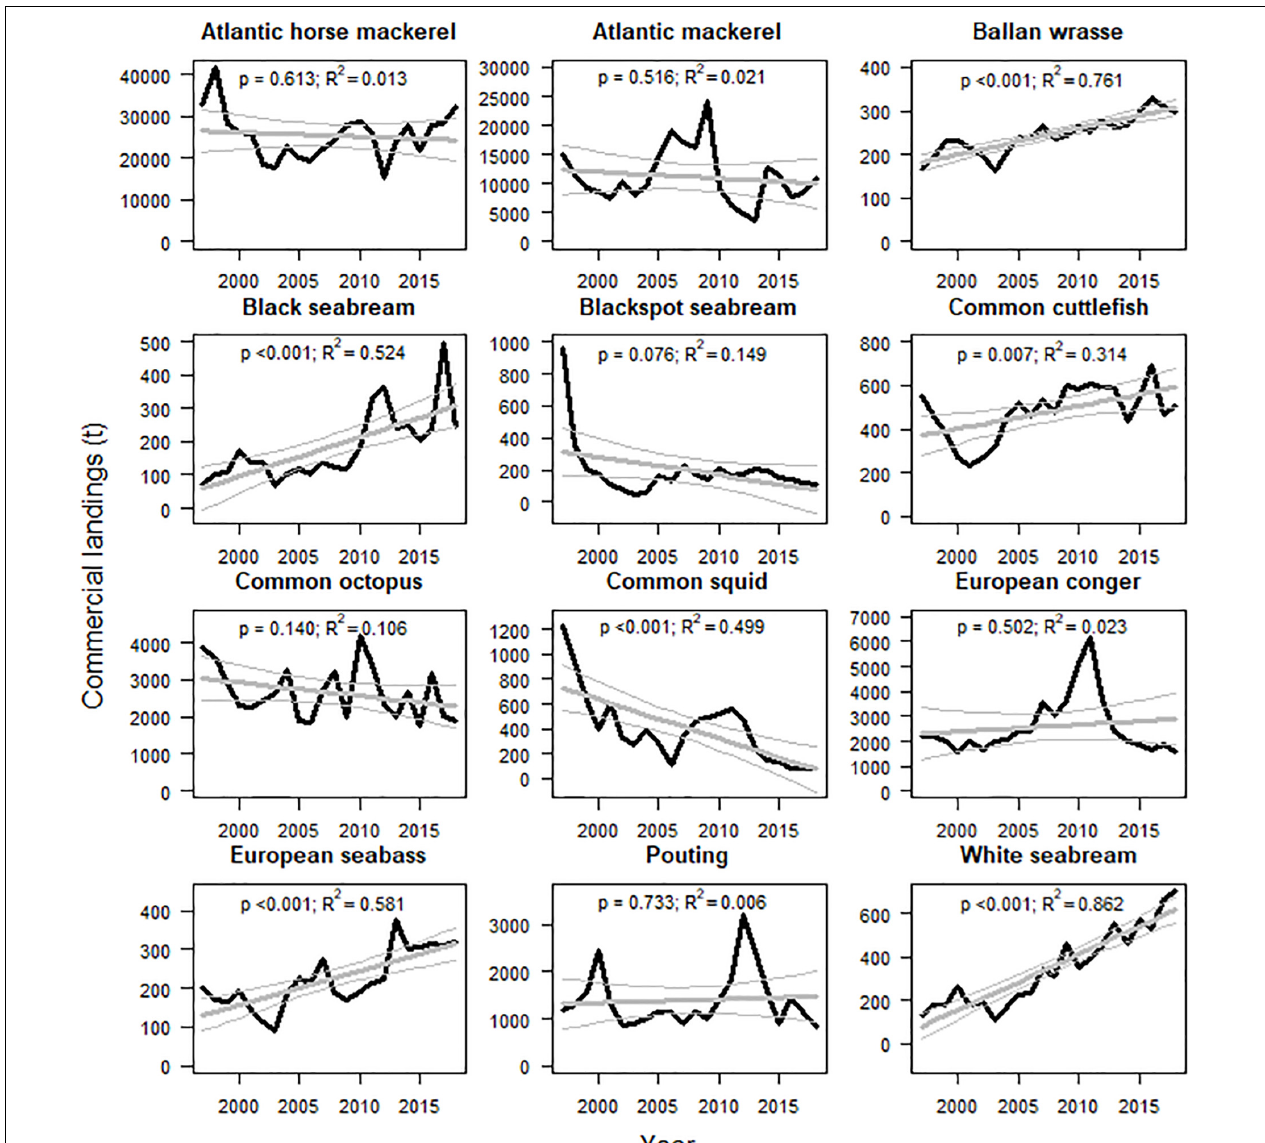
FIGURE 4 | Temporal trends in annual commercial landings in Galician ports of main species targeted by recreational fishers (1997–2018). Predictions (thick lines) and 95% confidence interval (thin lines) of the partial effect of the year on the landings estimated by GLM are showed in gray color. P -values and goodness of fit of the models ( R 2 ) are also